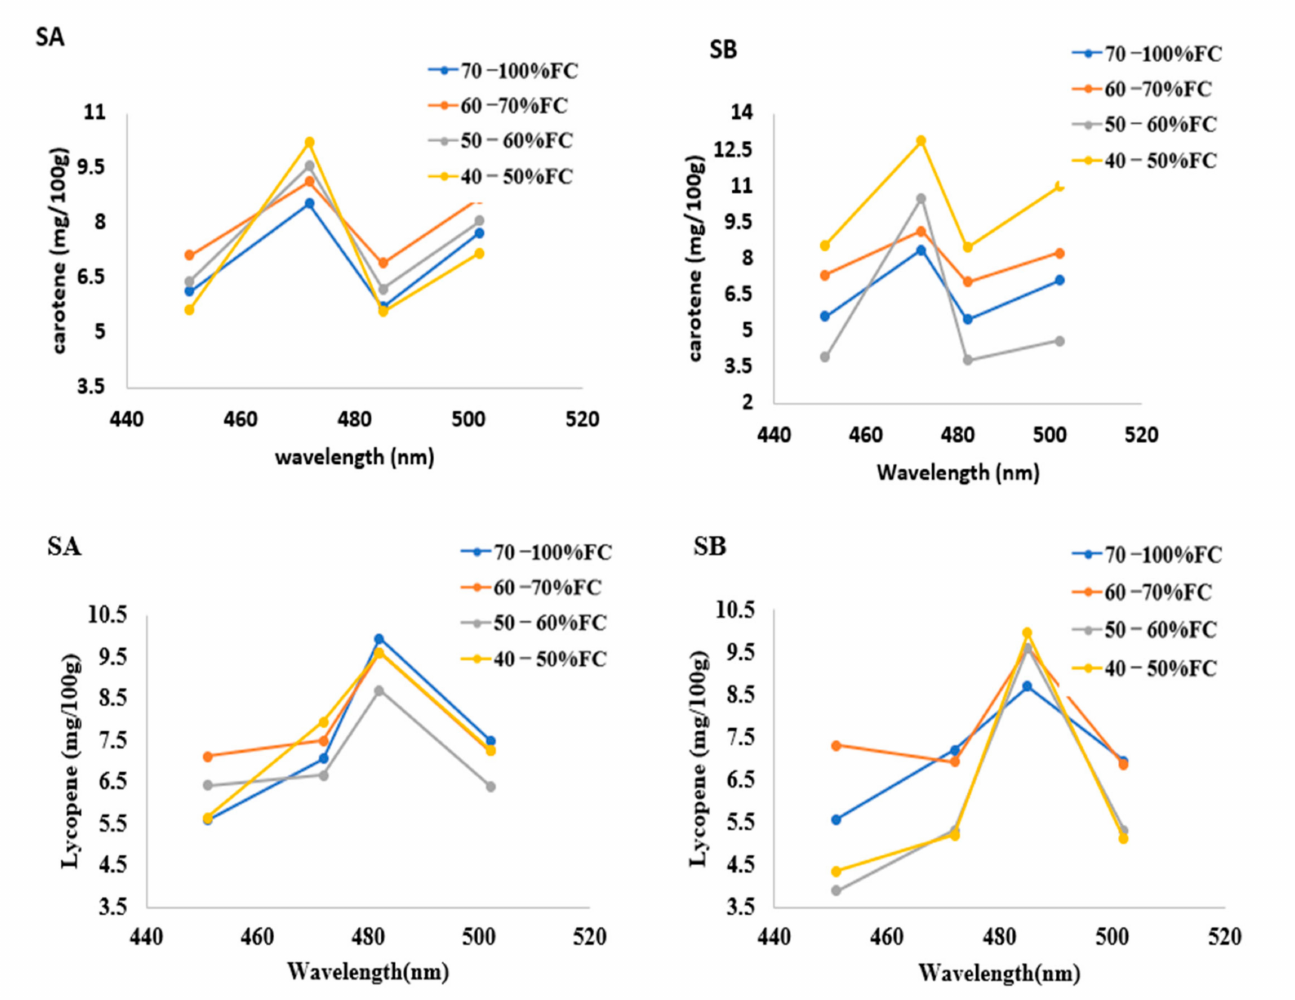
Figure 6. Absorbance spectra of β -carotene and lycopene under different water stress levels in two different soil types (SA = silty loam soil; SB = sandy loam